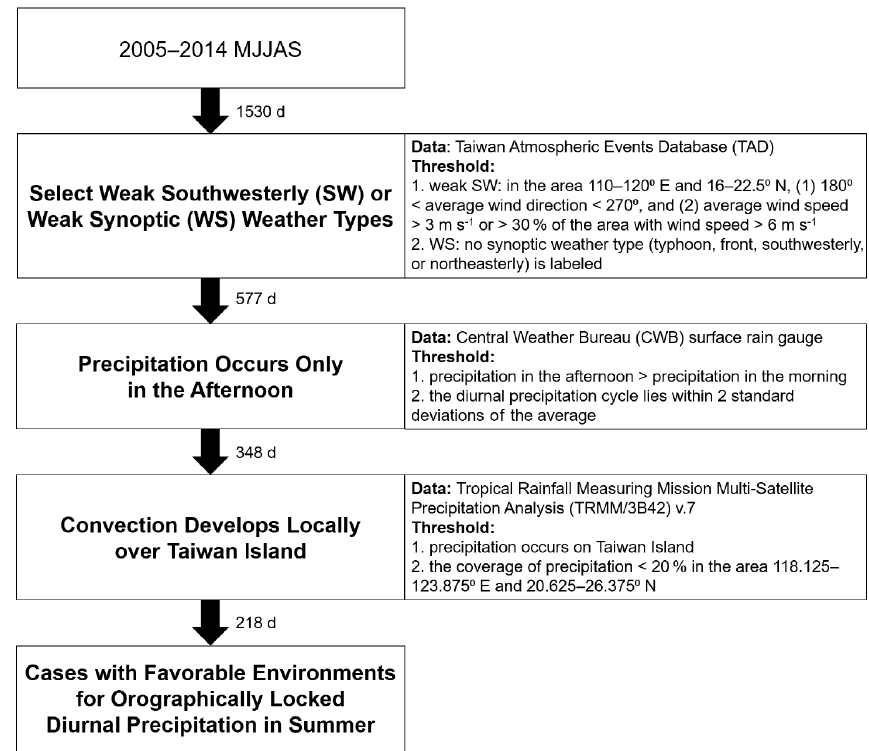
Figure 2. The procedure and data of case selection for semi-realistic simulations, aiming to find favorable environments for orographic locking diurnal precipitation under weak synoptic-scale weather forcing in